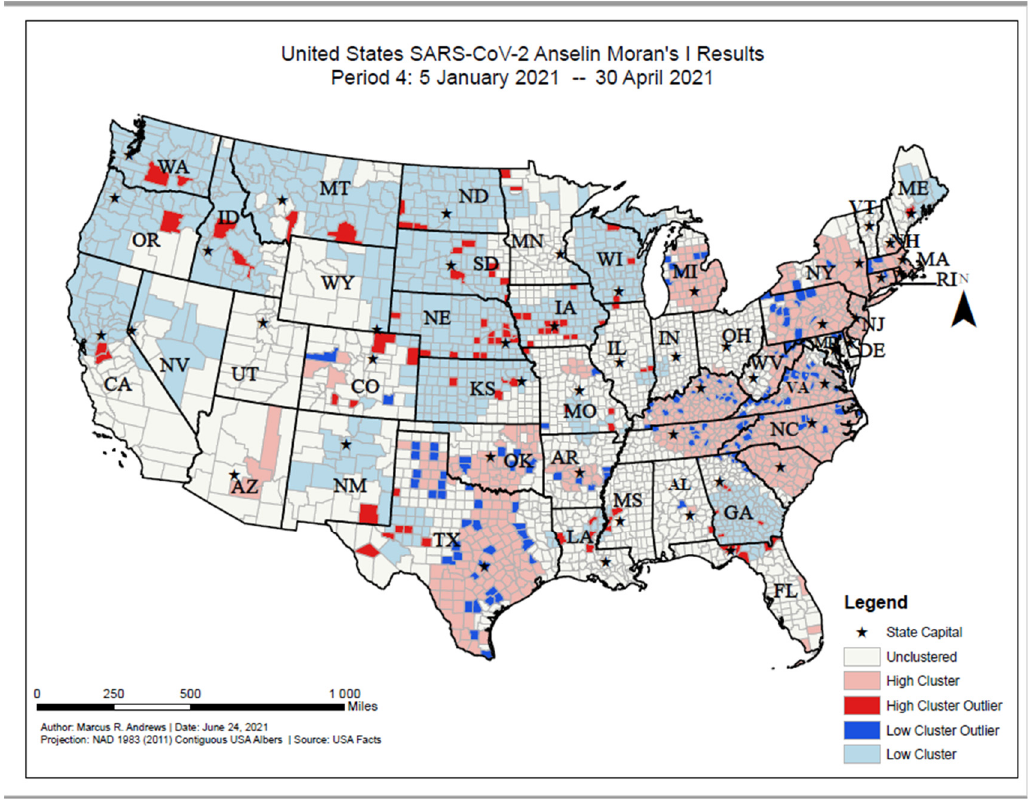
Figure 8. United States SARS-CoV-2 Anselin Moran’s I results, Period 4: 5 January 2021–30 April 2021.